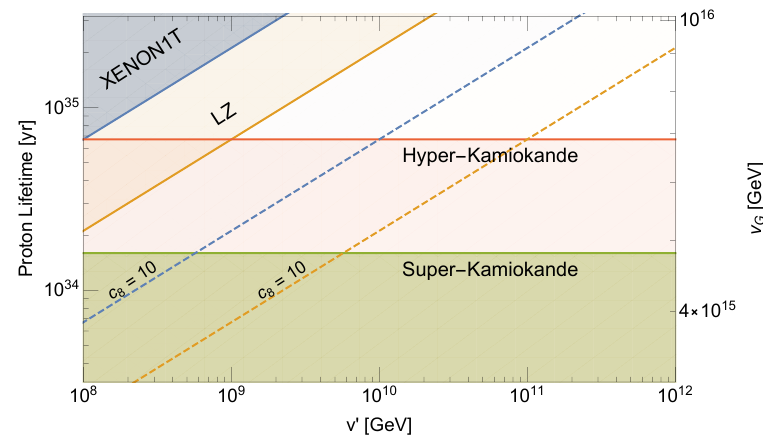
Figure 5 . Correlation between the proton decay rate and the DM-nuclear scattering rate as a function of v 0 . The rates are related as they both depend on the uni(cid:12)cation scale v G via higher- dimensional